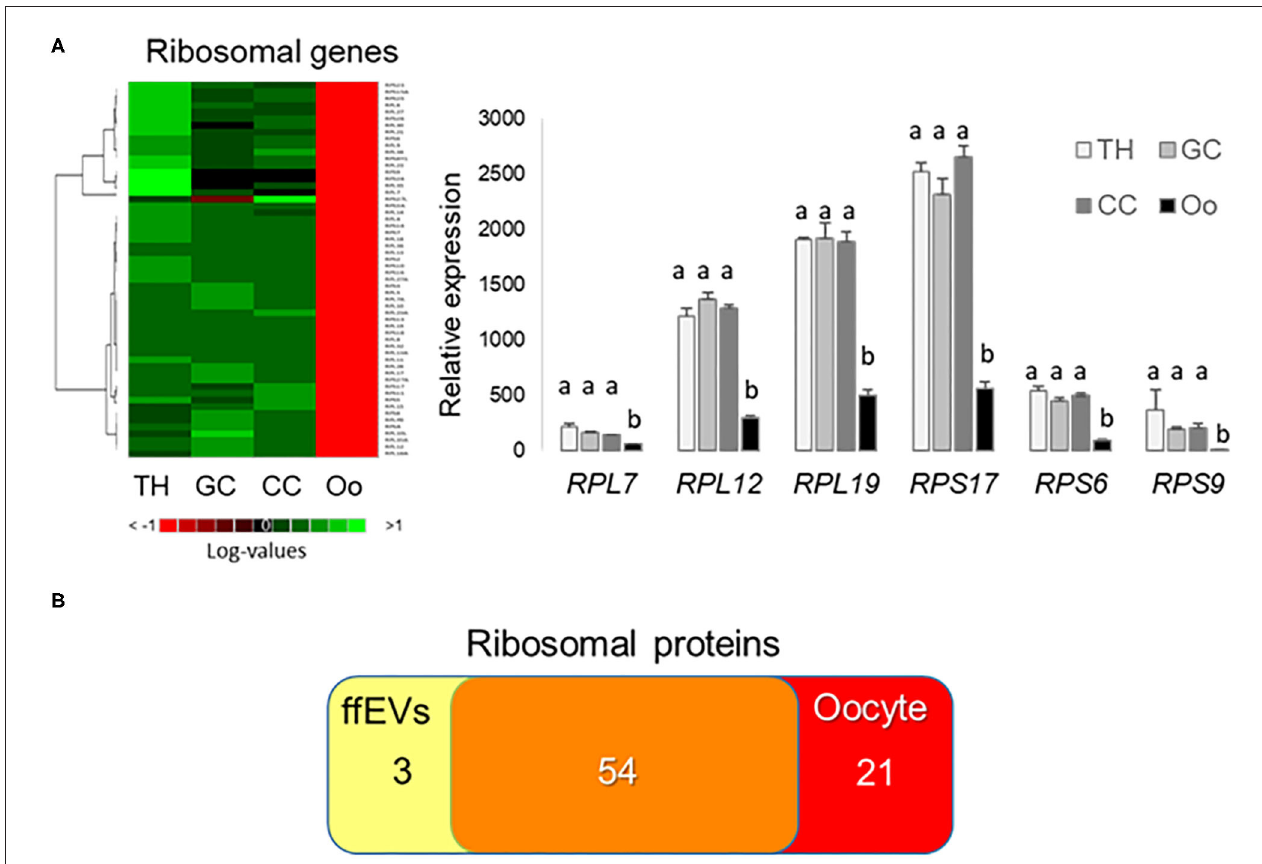
FIGURE 7 | Ribosomal proteins in follicular fluid exosome-like extracellular vesicles (ffEVs) and expression of corresponding genes. (A) Gene expression levels of small and large subunits ribosomal proteins in follicular theca cells (TH), granulosa cells (GC), cumulus cells (CC), and oocytes (OO). The heatmap represents log expression values of small and large subunit ribosome genes from different follicular cell types that were also identified in ffEVs. The graph includes mean ± SEM expression values for selected ribosomal proteins from four independent replicates. Different letters indicate differences at a significance level of p < 0.05. (B) Venn diagram representing a number of ribosomal proteins identified here in ffEVs and in bovine oocytes (